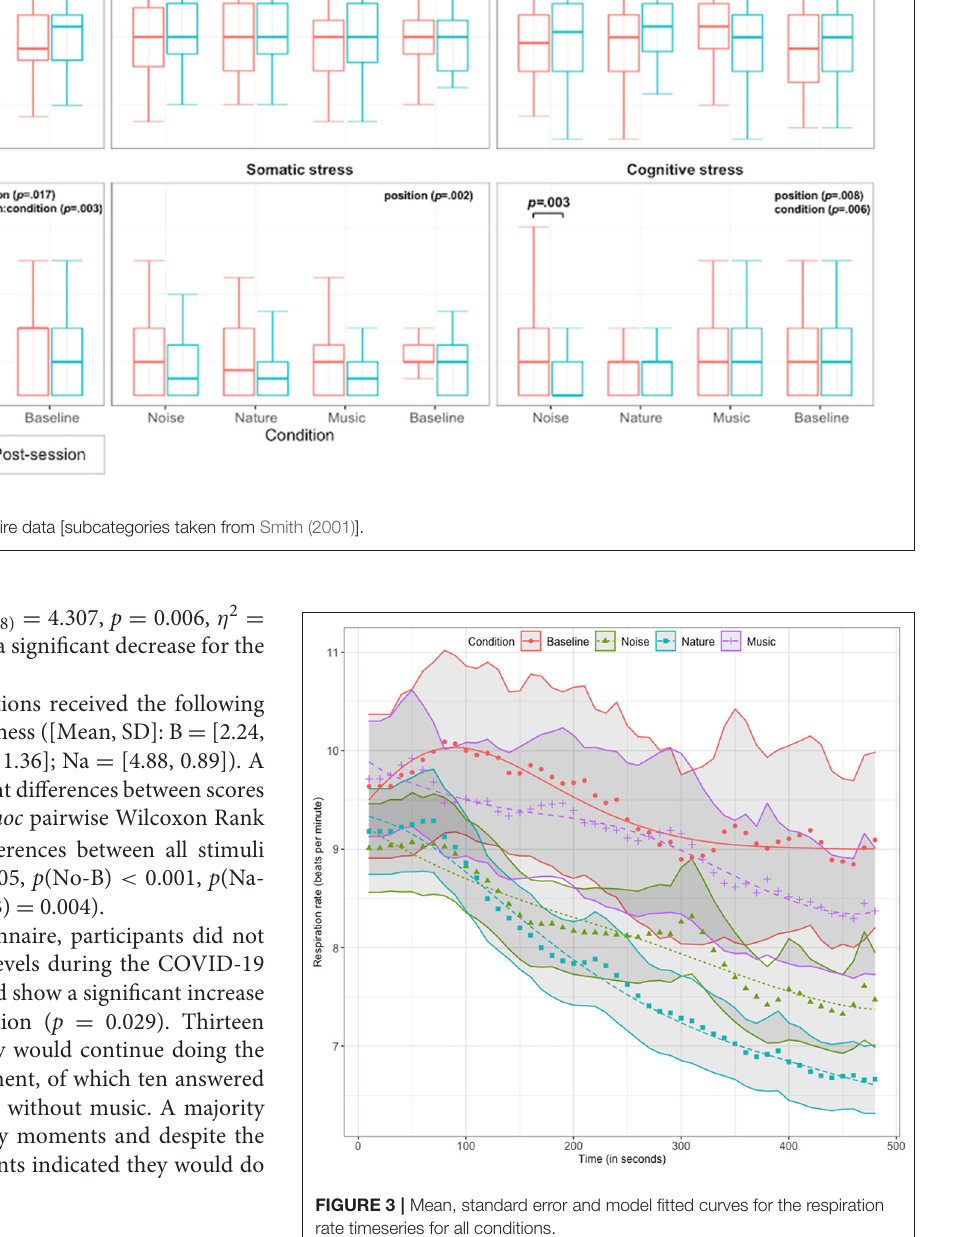
FIGURE 3 | Mean, standard error and model fitted curves for the respiration rate timeseries for all conditions.